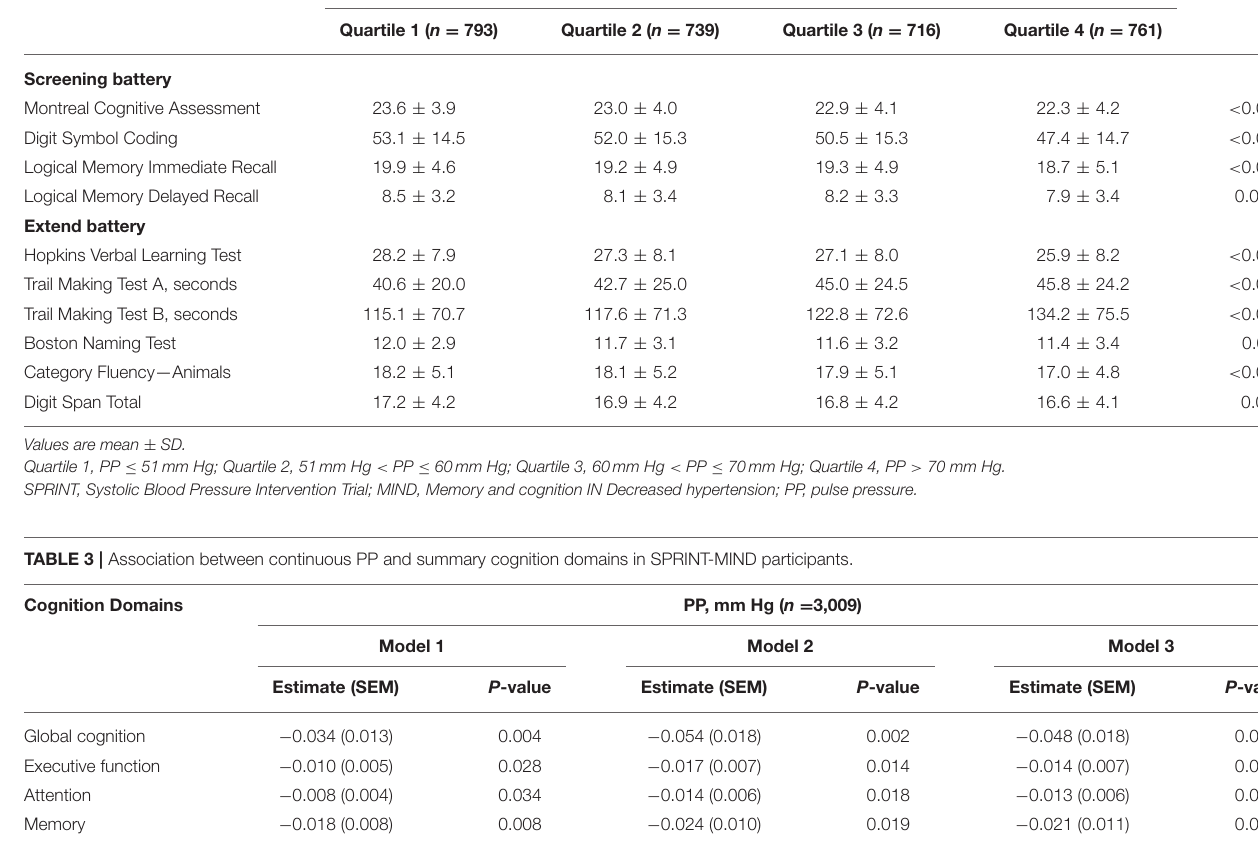
Screening battery Montreal Cognitive Assessment